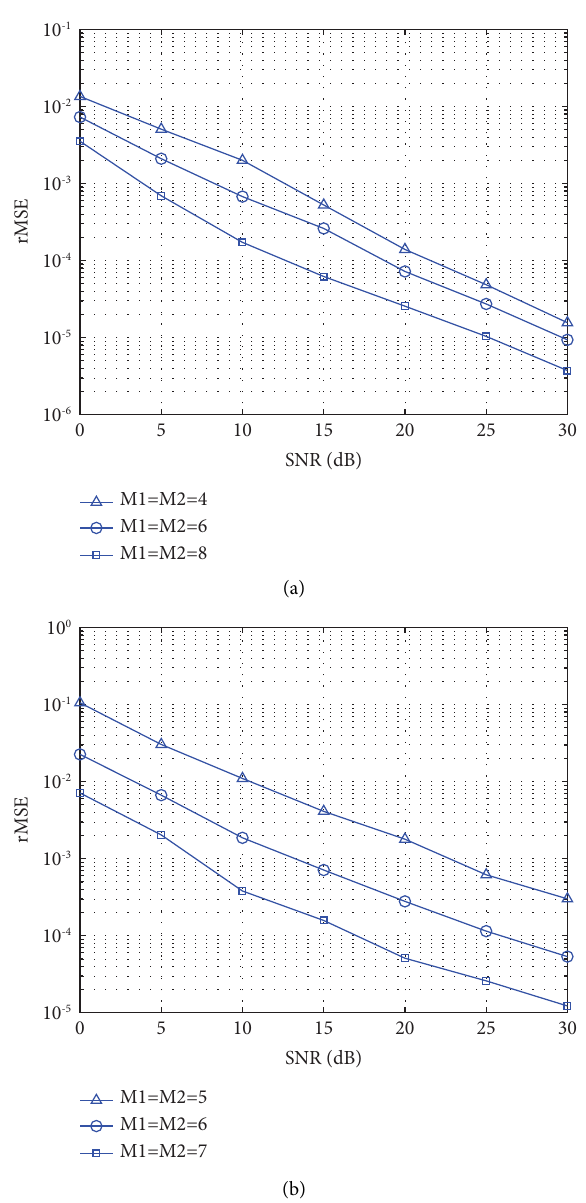
Figure 5: Te rMSE performance with a diferent number of antennas. (a) M